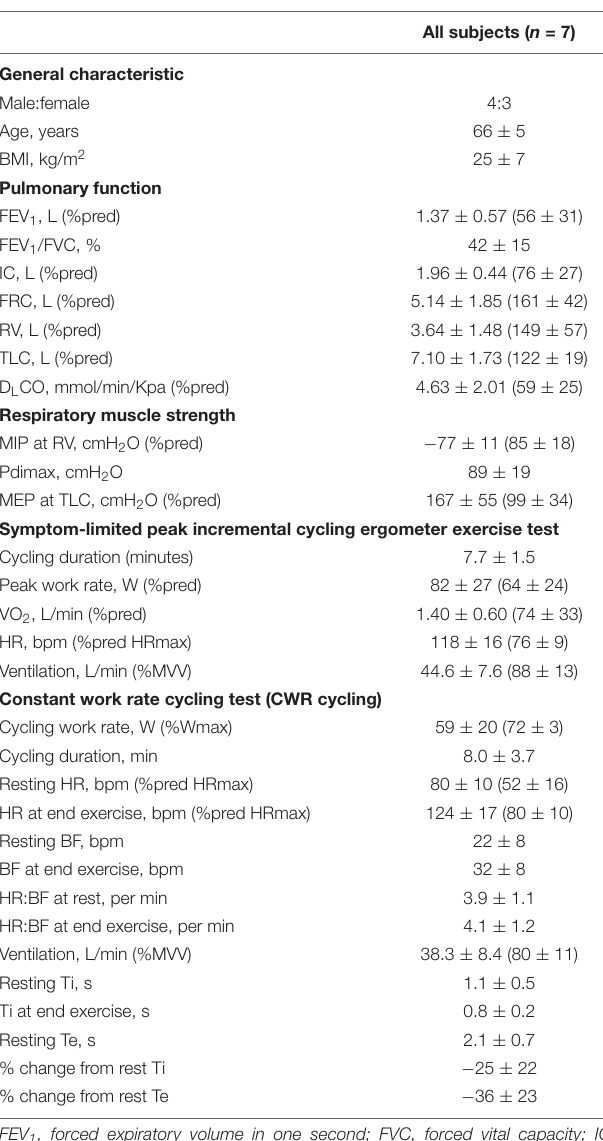
TABLE 1 | Patient characteristics: pulmonary function, respiratory muscle strength, maximal, and endurance exercise capacity.